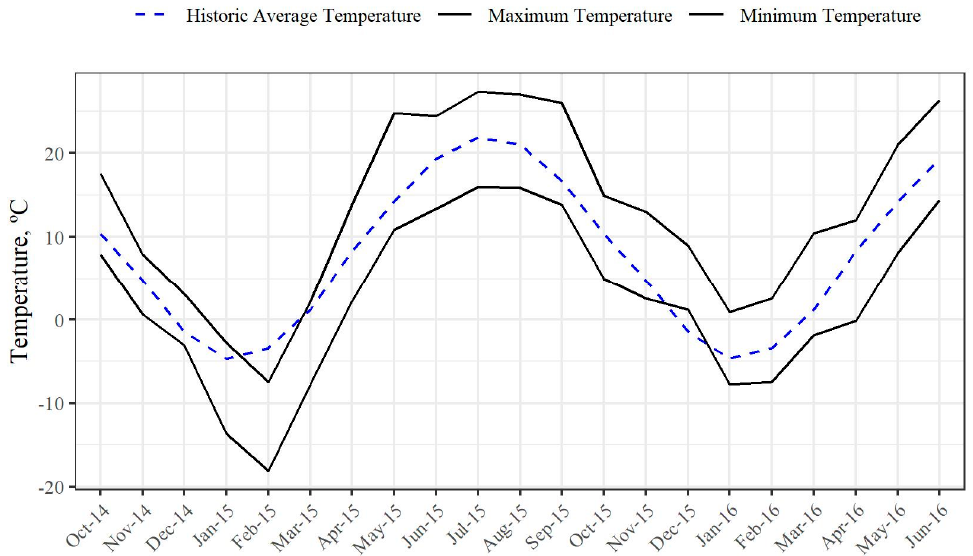
Figure 3. Historic temperatures as recorded between 1950 and 2010 at the Syracuse International Airport and actual temperatures measured on the OnCenter green roof from October 2014 to July 2016 [19].